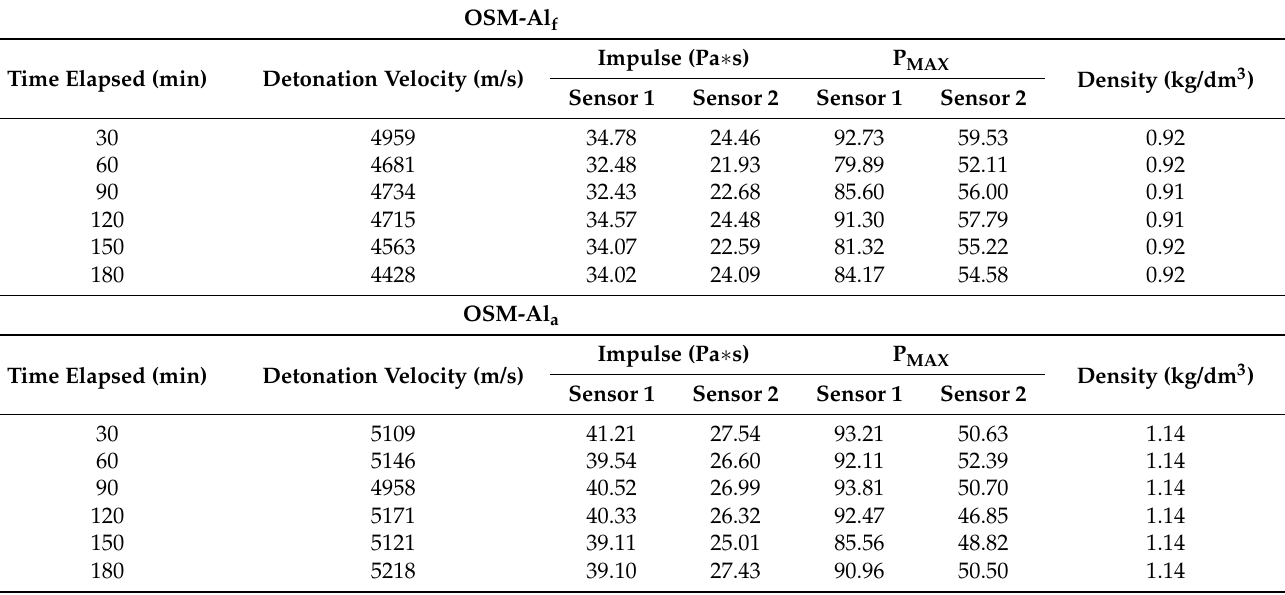
Table 3. Summary of the changes of the energetic properties of OSM charges over time elapsed from their preparation. OSM-Al f Time Elapsed